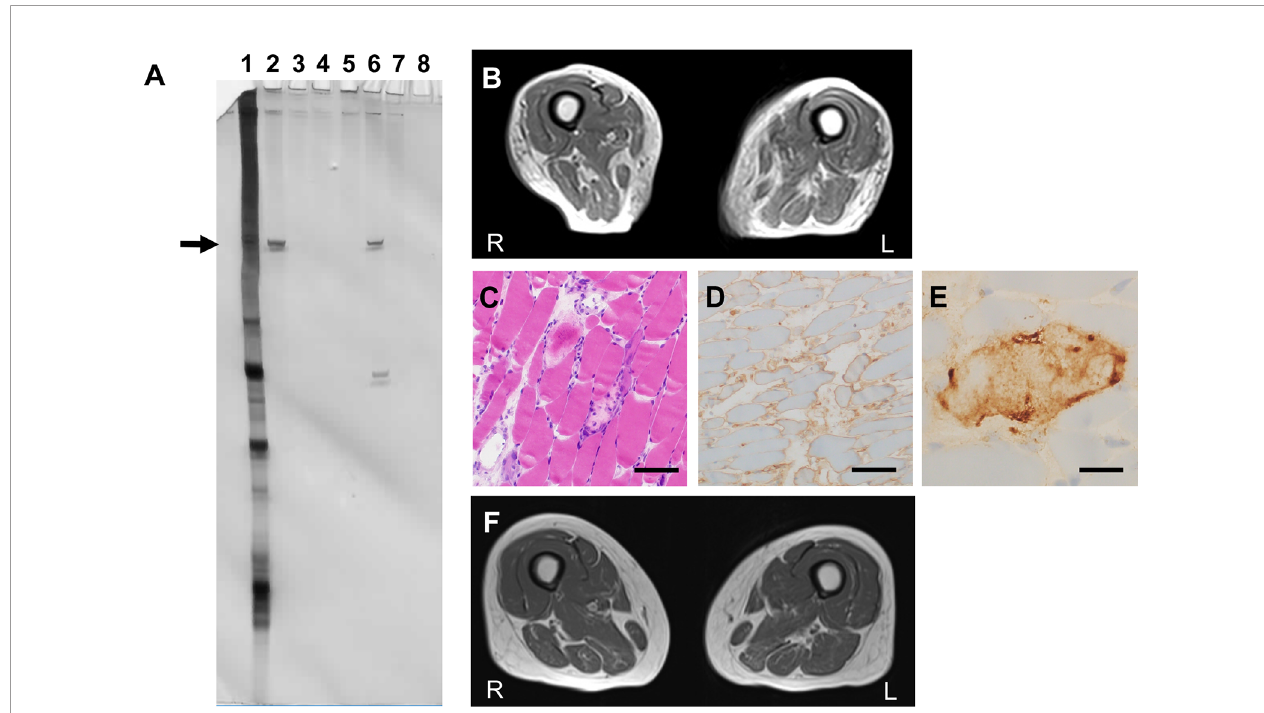
FIGURE 1 | Clinical features (A) RNA immunoprecipitation assay to detect anti-signal recognition particle (SRP) antibodies. Serum and tonsil tissue from a patient with chronic tonsillitis was used as control. Each tonsil was ultrasonicated and lysed in radioimmunoprecipitation assay (RIPA) buffer [50 mM Tris-HCl at pH 7.5, 150 mM NaCl, 5 mM ethylenediaminetetraacetic acid (EDTA), 0.5% sodium deoxycholate, 1% NP-40, and 0.1% sodium dodecyl sulfate (SDS)] and a protease inhibitor cocktail (Complete mini EDTA-free, Roche) at a concentration of 40 m g/ml. Anti-SRP antibodies were detected using an RNA immunoprecipitation assay